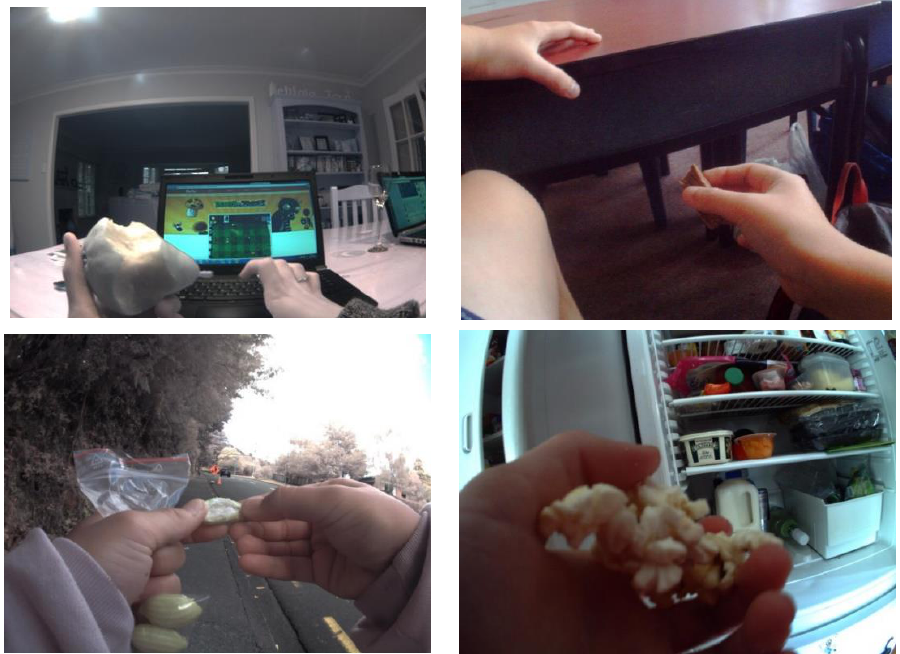
Figure 1. ( Top left ) snacking on pear at home; ( Top right ) snacking on chocolate in school; ( Bottom left ) snacking on candy on street; ( Bottom right ) snacking on popcorn at home.